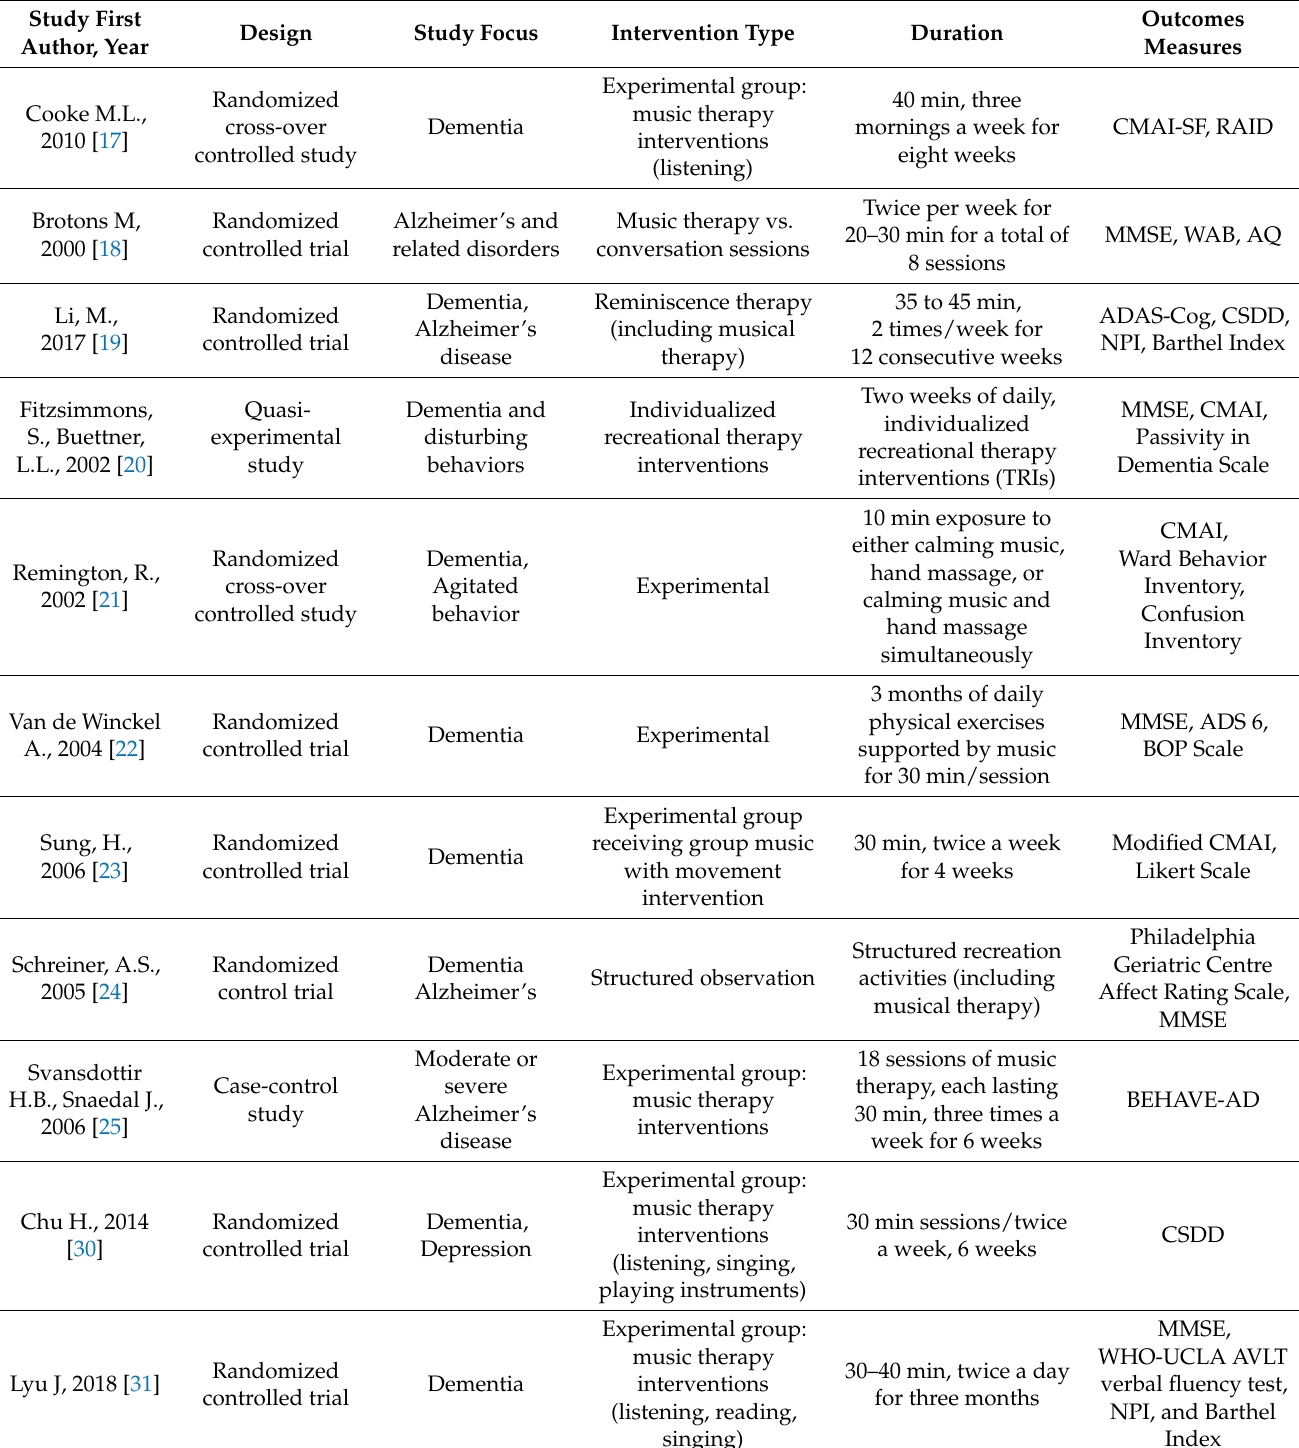
Table 2. Studies characteristics regarding musical